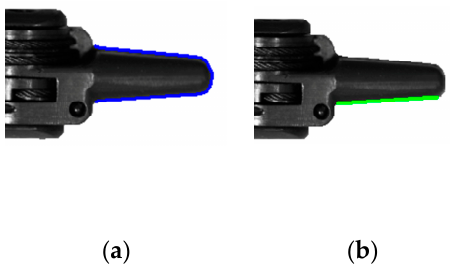
Figure 13. Edge extraction results of the images grabbed by the camera: ( a ) The sub-pixel precise edges of the end-effector’s tip; ( b ) The bottom edge of the end-effector’s tip.